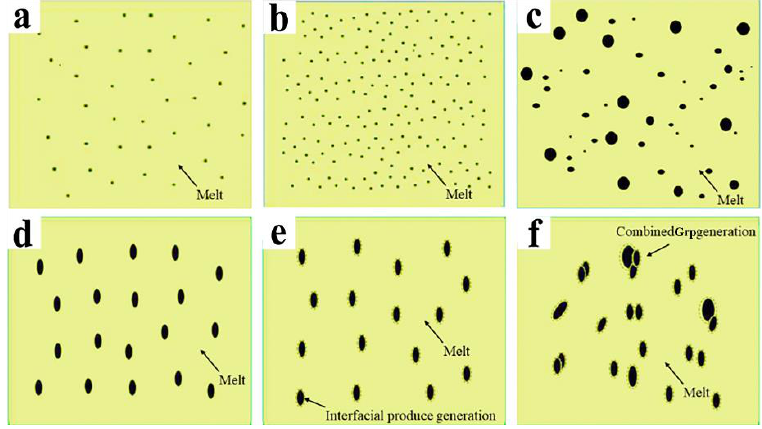
Figure 18. Illustration of the self-stabilization effect of Grp in the melt: ( a ) a small amount of Grp added to the melt, ( b ) a large amount of Grp added to the melt, ( c ) the agglomeration of Grp in the melt, ( d ) Grp added to the melt (enlarged drawing), ( e ) Grp edges producing the interface product, and ( f ) the production of the combined Grp particles.